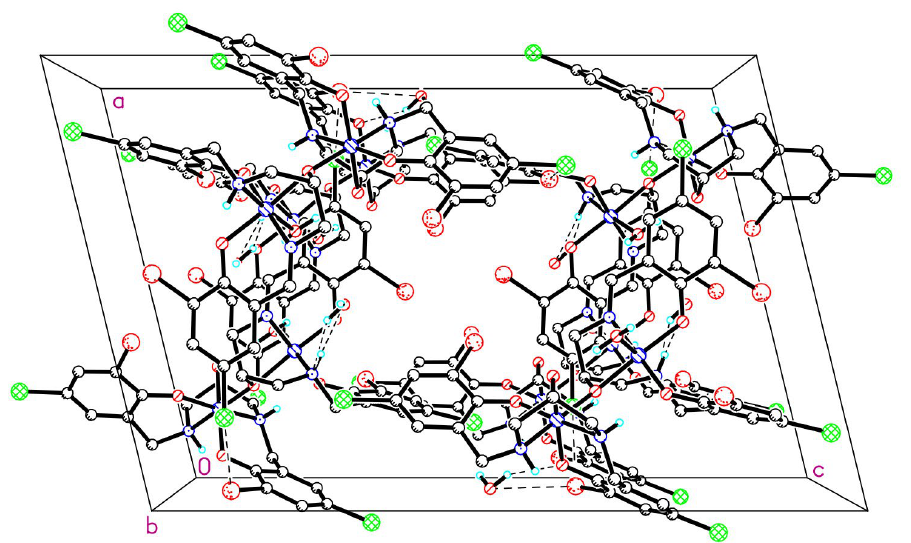
Fig. 4. Molecular packing structure of 2 . Hydrogen bonds are shown as dashed lines.